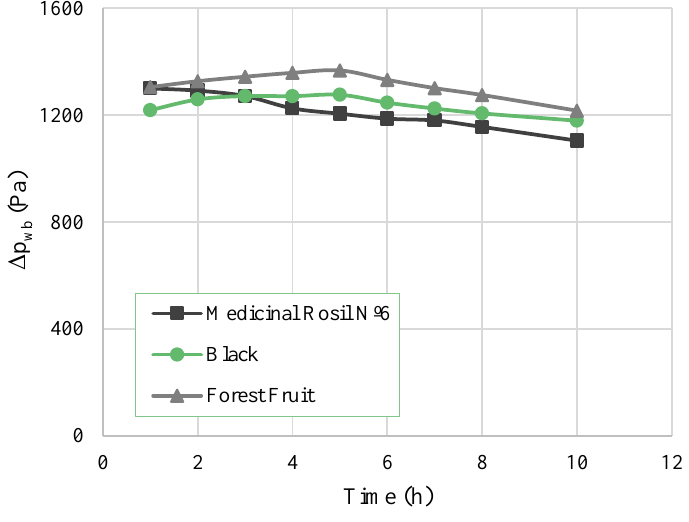
Figure 5. Overall driving force as a function of the time.